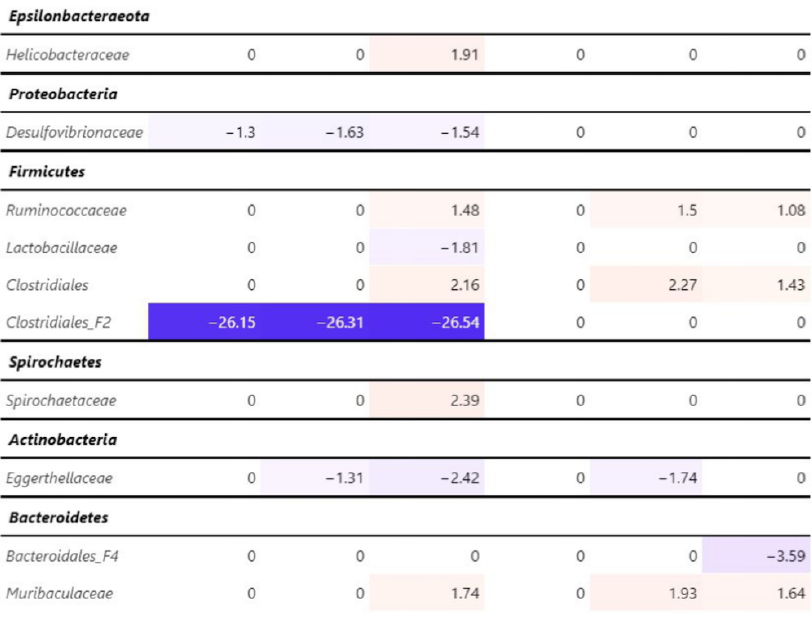
Table 2- Pairwise comparisons of the relative abundance of the gut bacteriota between sampling localities. Mont = Mont- sous-Vaudrey, Chau = Chaux-des-Croteay, Chat = Chatillon, Corm = Cormaranche. The Log² fold value is indicated for significant changes in abundance between two localities. Blue and red colors respectively correspond to negative and positive values. Higher absolute changes in Log 2 fold are emphasized with darker colors. The notation "order_fx" or “class_fx” is used when there was no assignation at the family level with the SILVA database. Phylum is indicated in